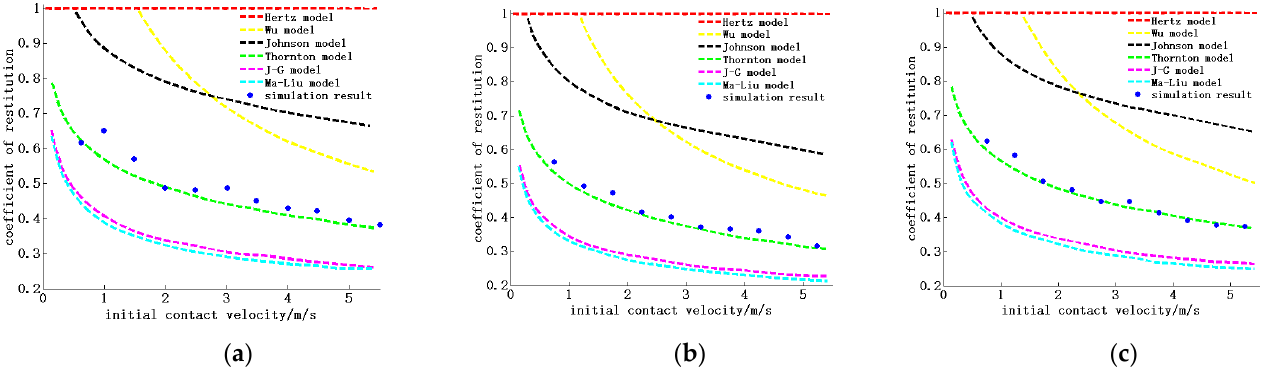
Figure 5. Influence of different materials on the coefficient of restitution: ( a ) collision of steel balls and rigid plates, ( b ) collision of aluminum balls and rigid plates, ( c ) collision of copper balls and rigid plates.